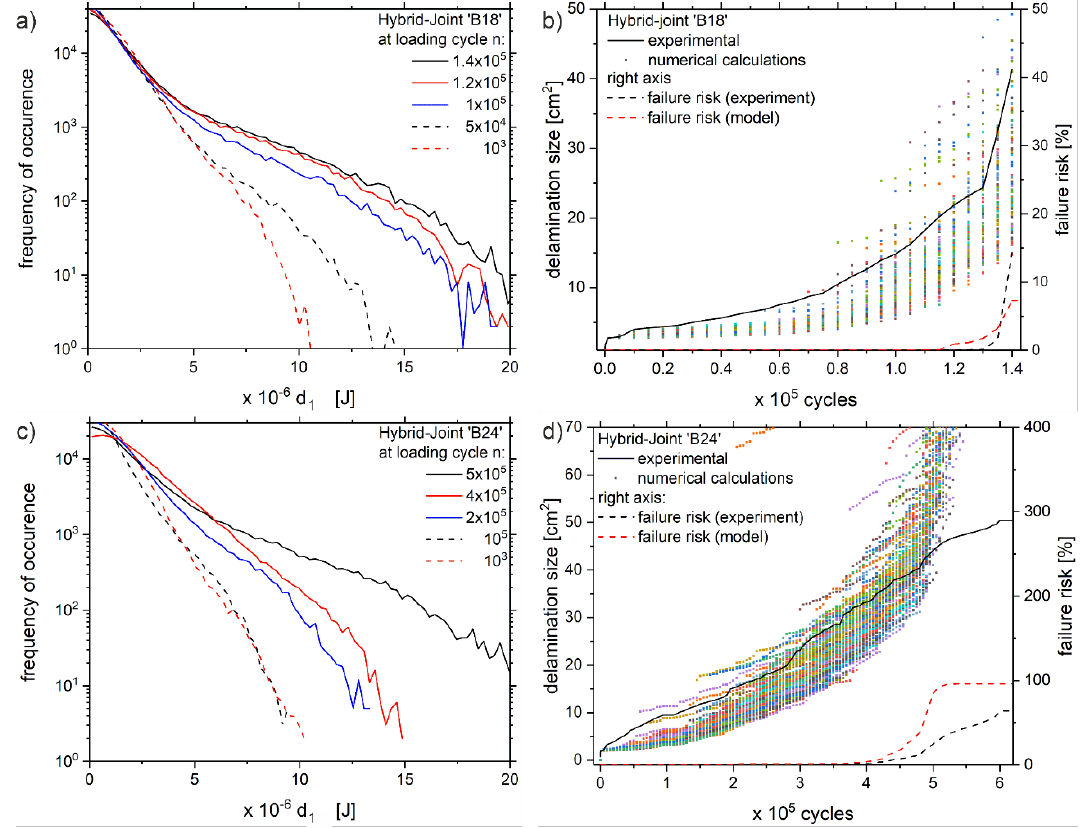
Figure 10. Distribution of dissipation values d 1 for samples ( a ) ‘B18’ and ( c ) ‘B24’ at five different measuring times n, with the corresponding evolution of delamination size during the experiments of ( b ) ‘B18’ and ( d ) ‘B24’, including experimental data (solid line), probabilistic calculated defect size (colored dots) and the resulting failure risk (dashed lines, referring to right axis).